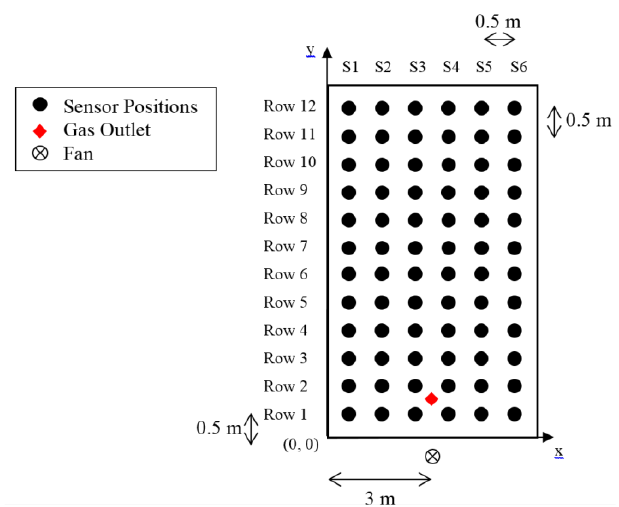
Figure 2. Sensor positions in the array.